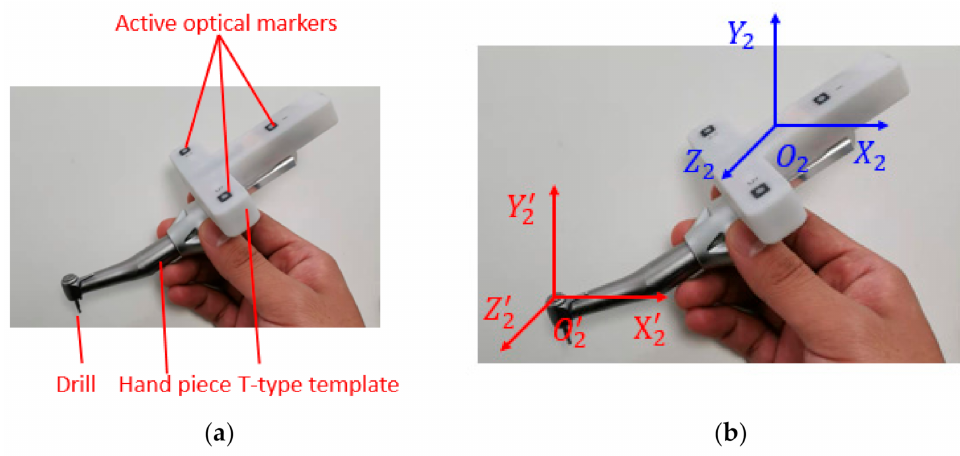
Figure 5. Self-designed implant instrument ( a ). Component, ( b ) coordinate system